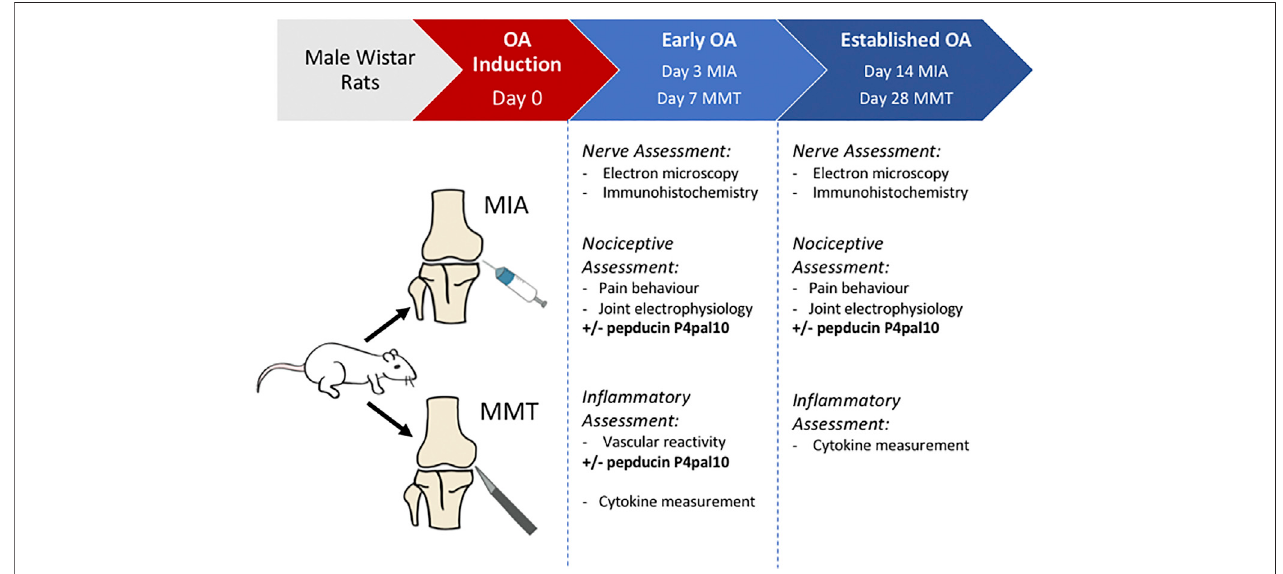
FIGURE 1 | Experimental timeline. Experimental OA is induced in male Wistar rats using either intra-articular injection of sodium monoiodoacetate (MIA), or medial meniscal transection (MMT) surgery. In vivo and ex vivo assessments of OA animals are undertaken during an early stage (day 3 MIA, day 7 MMT) or an established/late stage (day 14 MIA, day 28 MMT) of the disease. Naïve animals were used as a control.